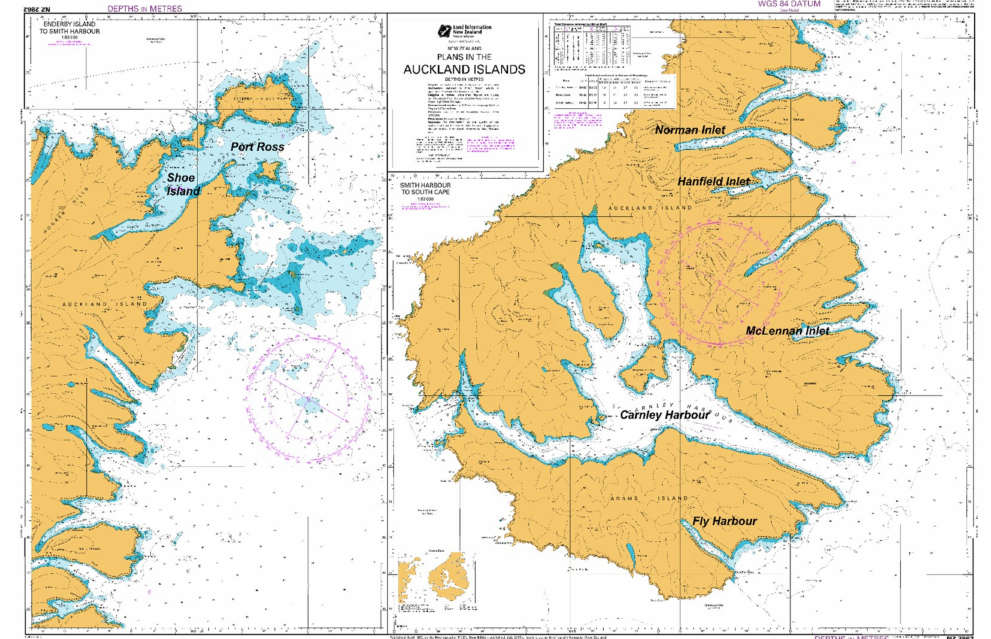
Figure 2. Annotated chart NZ2862, 2017 edition © LINZ (Downloaded from LINZ Data Service